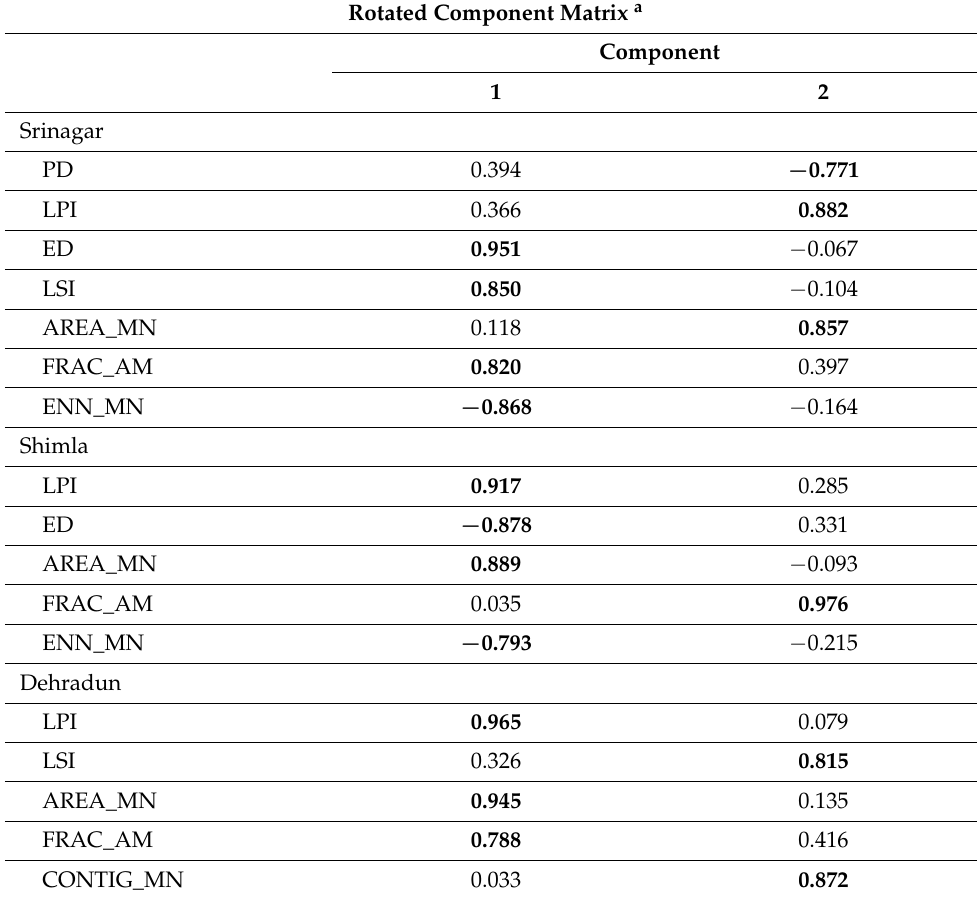
Table 3. Loading factors of selected components (in bold) for each city. Rotated Component Matrix